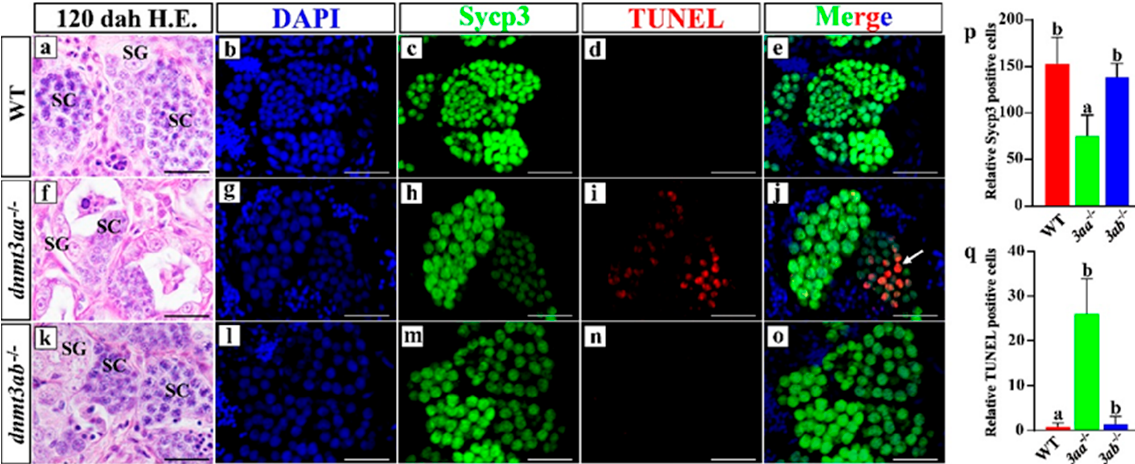
Figure 5. Apoptosis detection in WT, dnmt3aa − / − and dnmt3ab − / − ovaries at 60 dah. Increased apoptosis of germ cells in the ovaries of dnmt3aa − / − fish at 60 dah. ( a , f , k ) Histological analyses of germ cells by H&E staining. ( b , g , l ) Nuclei were counterstained with DAPI. ( c , h , m ) Green fluorescence represents the Vasa signals. ( d , i , n ) Red fluorescence represents the TUNEL-positive signals. ( e , j , o ) Co-localization of some Vasa and TUNEL signals as indicated by orange color in Nile tilapia ovaries. ( p ) Germ cell count of WT, dnmt3aa − / − and dnmt3ab − / − ovaries at 60 dah. ( q ) TUNEL-positive germ cells in the median section of the ovaries (part2) ( n = 5 for each genotype). Results are presented as mean ± SD. Different letters above the error bar indicate statistical differences at p < 0.05 as determined by one-way ANOVA followed by Tukey’s post hoc test. dah, days after hatching. Scale bar, 10 μ m. OC, oocytes; OG, oogonia. The white arrow indicated co-localization of Vasa and TUNEL signals.